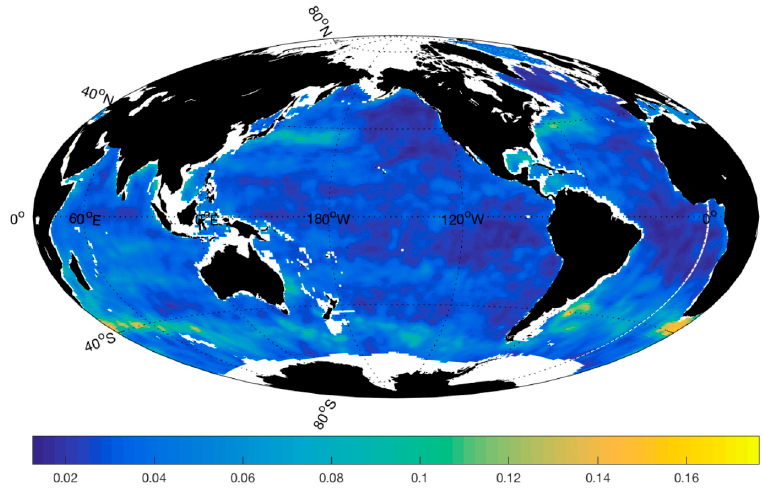
Figure 3. RMSs of the sea level anomaly (unit: m).